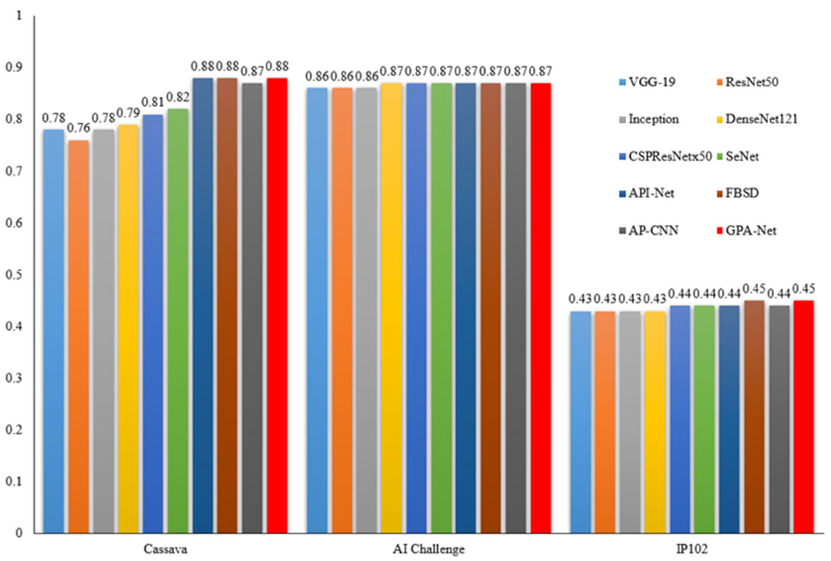
Figure 6. F1 scores for different models on different datasets.